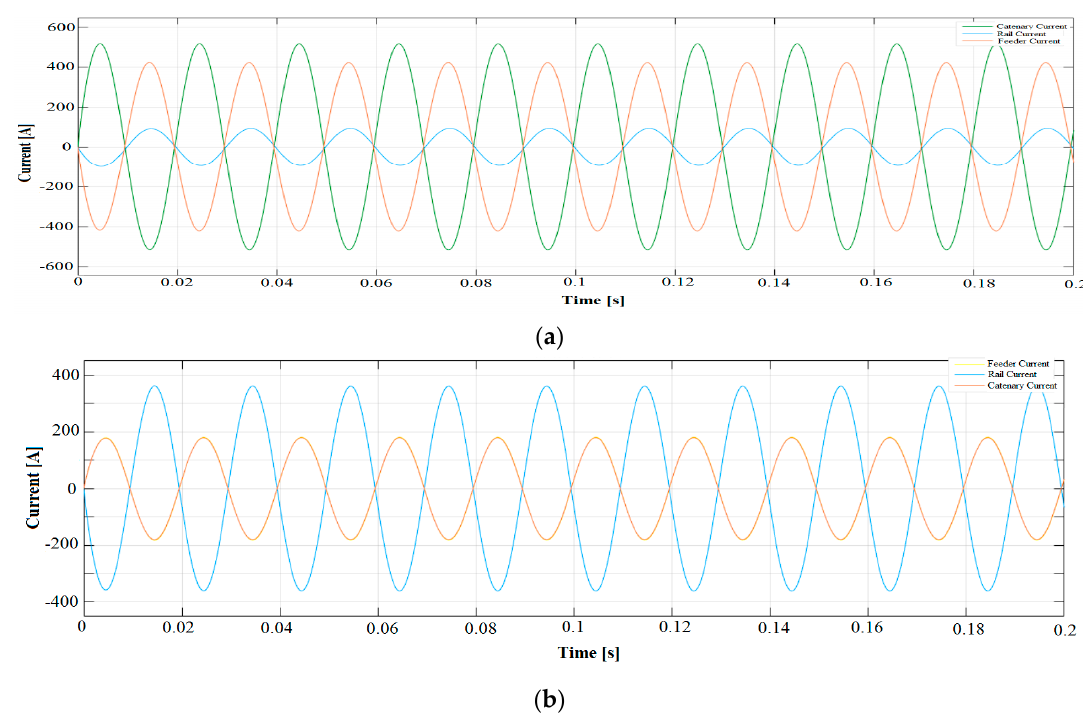
Figure 9. Currents measured on the ( a ) feeding transformer connections and ( b ) autotransformer connections with trains as the only load.